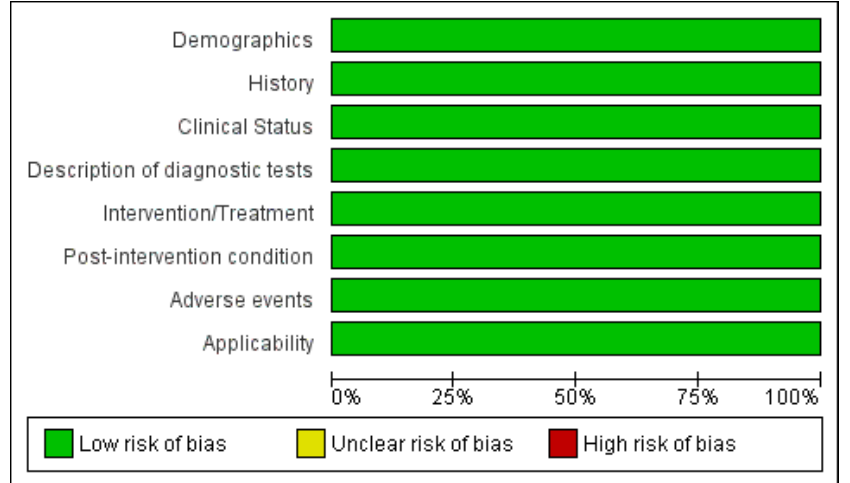
Figure 6. Reporting guidelines summary: review authors’ judgements about reporting on each criterion for each included study [27,28].